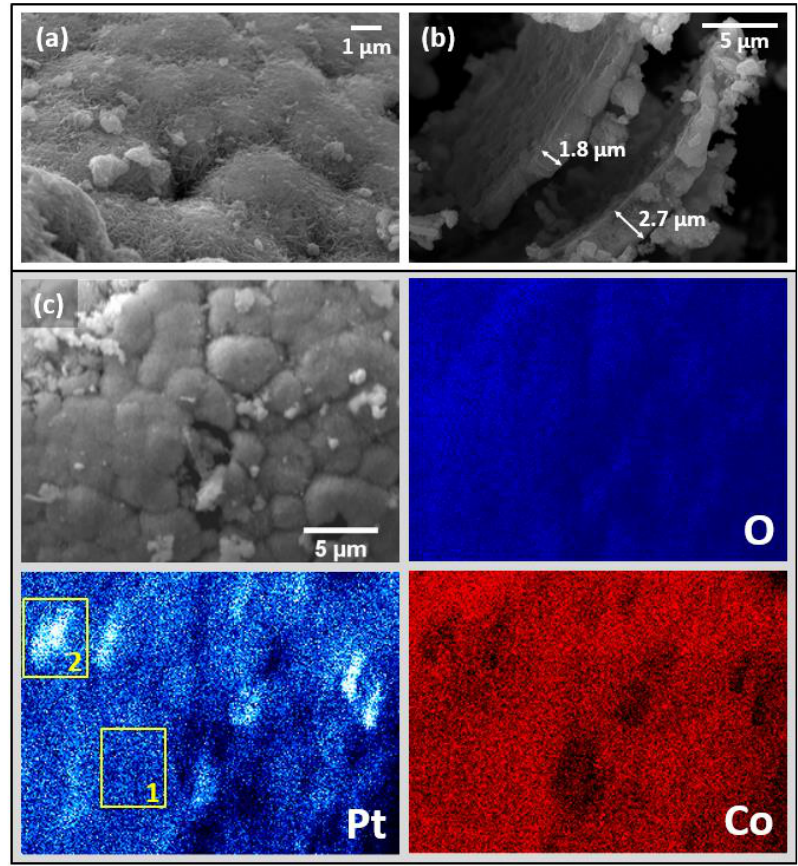
Figure 5. SEM ( a , b ) and EDX element mapping ( c ) of Pt 2.5 Co 97.5 . Rectangle 1 is an area with uniformly distributed Pt particles. Rectangle 2 is an area with elevated Pt concentrations.